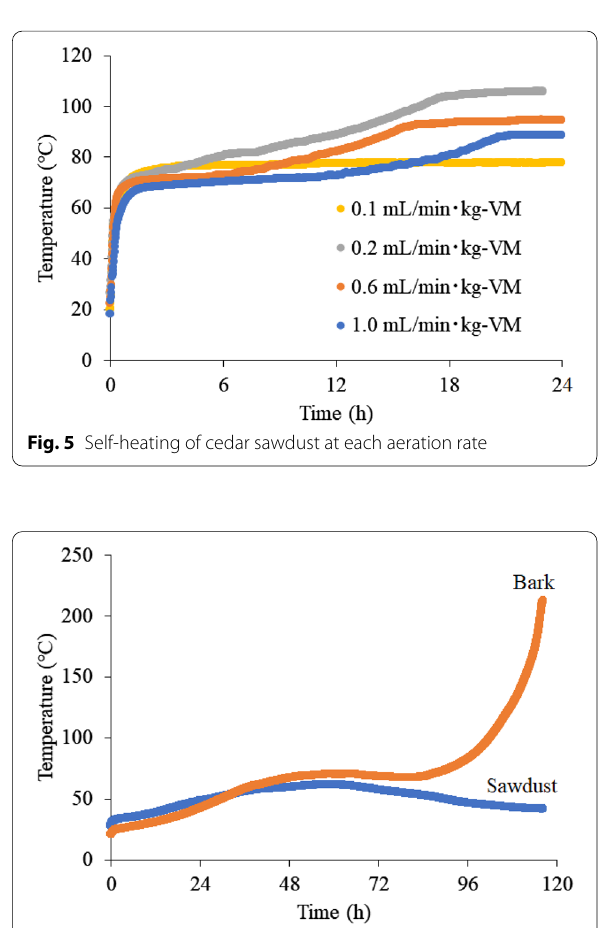
Fig. 6 Self-heating of sawdust and bark chips